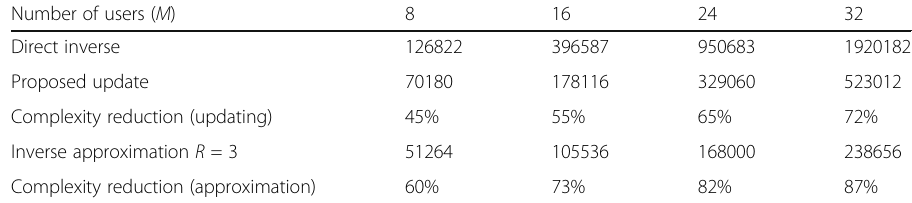
Table 2 Numbers of complex-valued operations required for the ZF STBC decoder: a user is added to the system